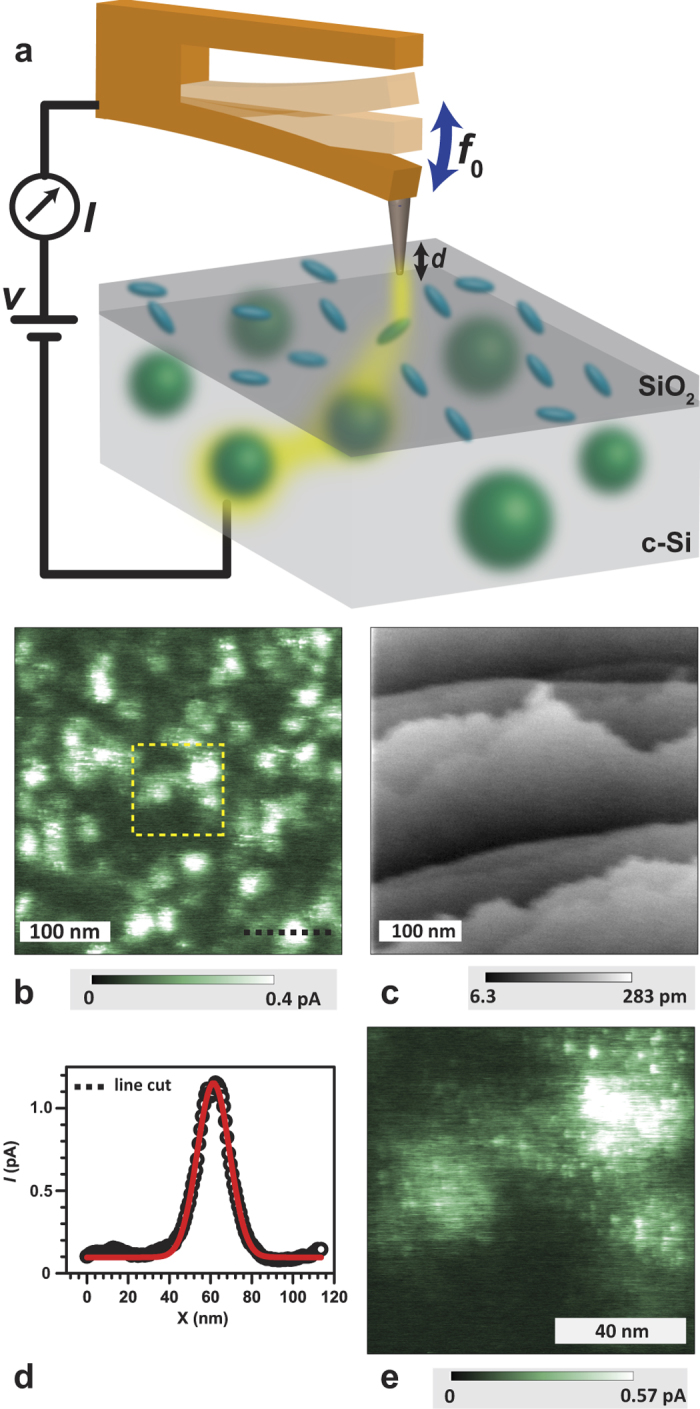
(a) Schematic of the low-temperature current imaging experiment conducted on a phosphorus doped silicon substrate. A quartz tuning fork (qPlus sensor) with a Pt tip attached oscillates at f0 ~ 30 kHz. When a bias voltage V is applied to the probe, electrons tunnel from highly localized silicon dangling bond (blue ellipsoids) into the Pt tip. Due to high density of P dopants (indicated by green spheres), the substrate allows for percolation (path indicated by yellow halo) of charges through the bulk. Thus, recharging of the emptied dangling bond state through recombination is possible from a nearby P atom if the donor-dangling bond proximity permits. (b) Current map of a P doped, flash cleaned c-Si substrate without any silicon dioxide at 4.3 K in darkness. The tip-bias voltage applied for this measurement is 1.3 V. The bright patches represent the spatial distribution of charge percolation endpoints indicating electronic states consistent with the localization and density of P donor atoms. (c) AFM topography image taken simultaneously using the interaction between surface and probe. The individual step edges are resolved. Note the absence of correlation between the current map and the surface topography. We also note that this AFM topography image displays a very weak, albeit recognizable ghost image in the upper right corner of the imaged area. (d) Line profile of one patch as indicated by the dotted black line in (b). The FWHM of the Gaussian fit (red) of this patch is ~18 nm, corresponding to approximately 3 Bohr diameters of the P donor wave function. (e) High resolution image of the area indicated by the yellow box in (b) using identical condition of (b). A distinct, seemingly random fine structure for some of the patches attributed to the P donors is visible.